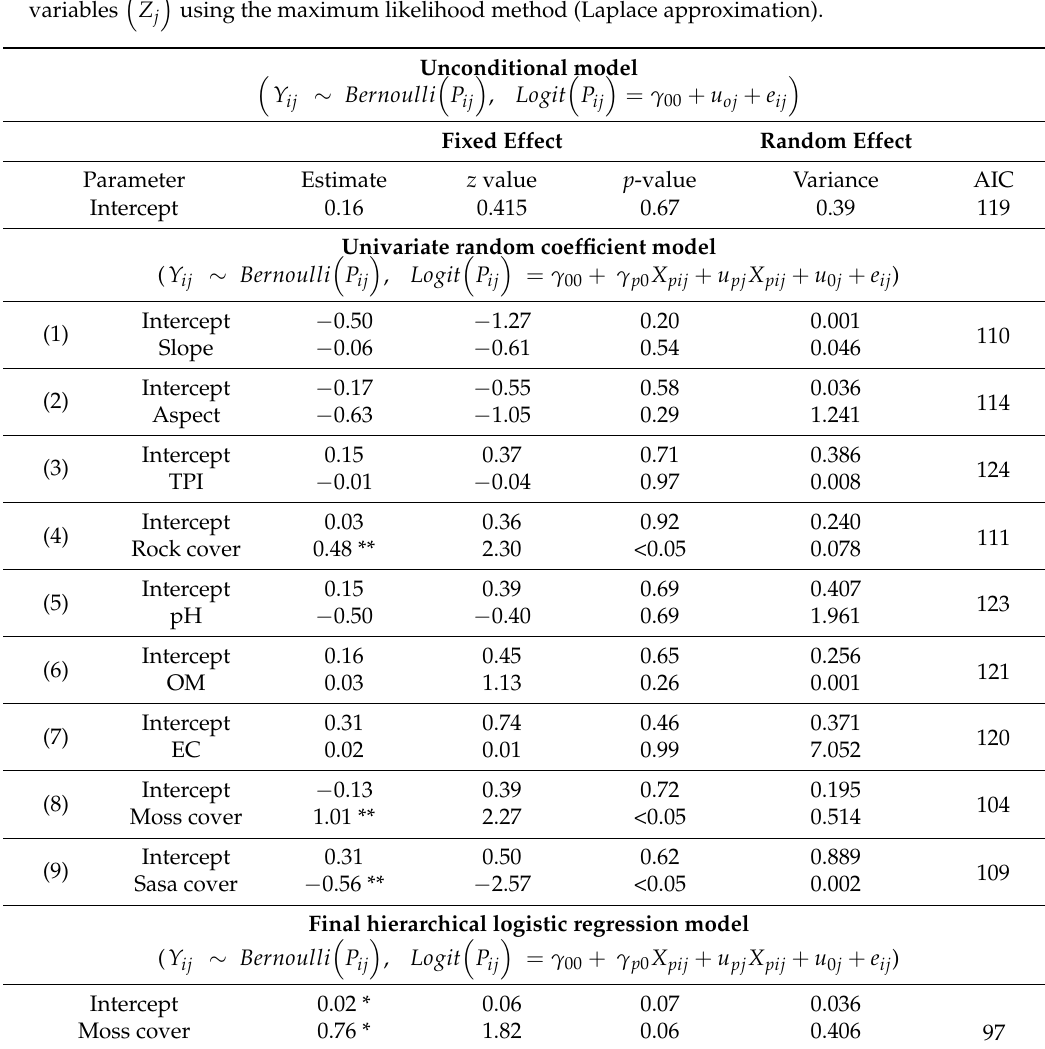
(cid:17) (cid:16) X ij and site-level explanatory